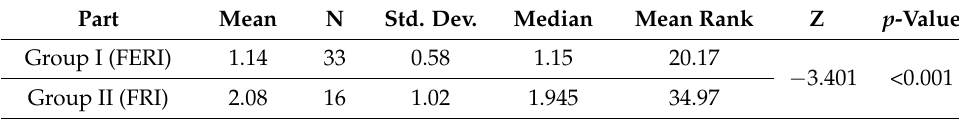
Table 6. Comprehension efficiency of the first test (Mann–Whitney Test).